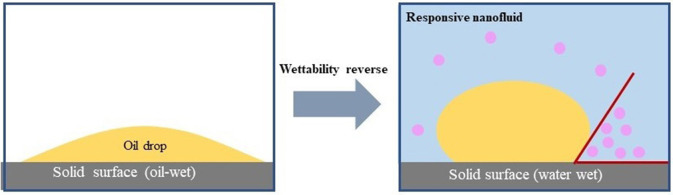
Mechanism of wettability alteration induced by the responsive nanofluid (Wasan et al., 2011).